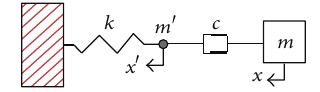
Figure 4: Maxwell spring-damper